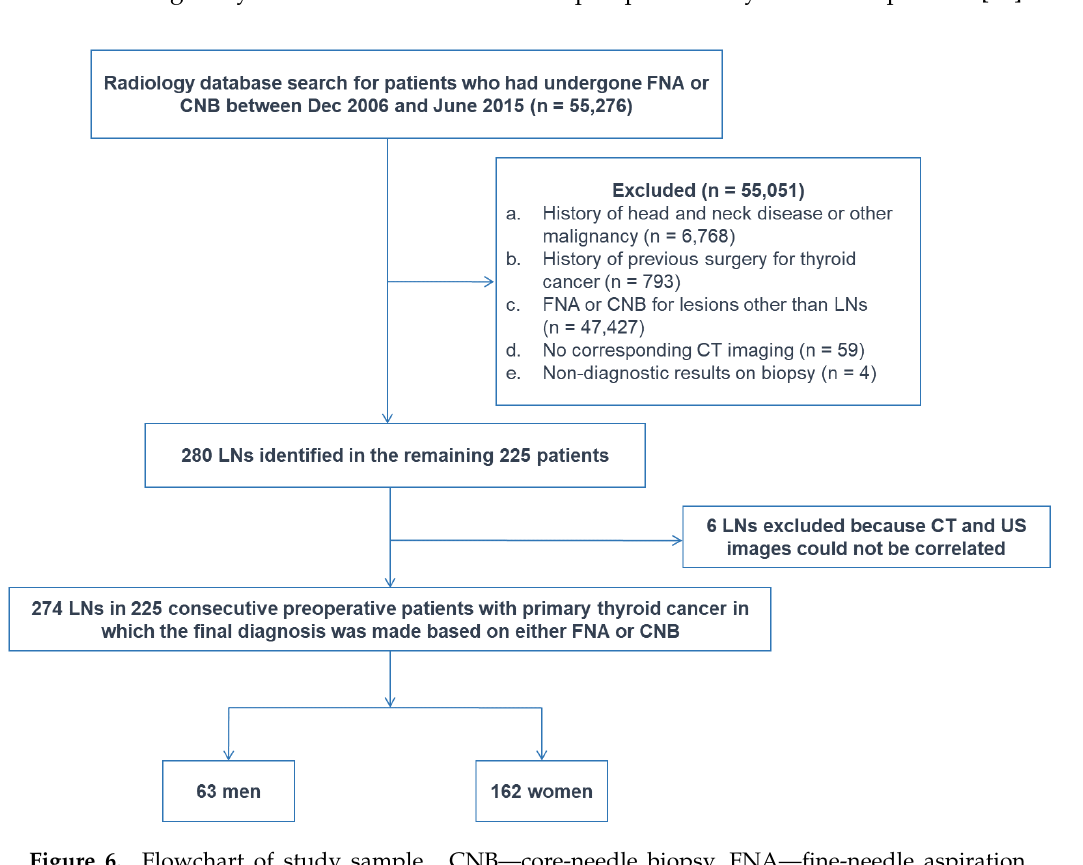
Figure 6. Flowchart of study sample. CNB—core-needle biopsy, FNA—fine-needle aspiration, LN—lymph node.